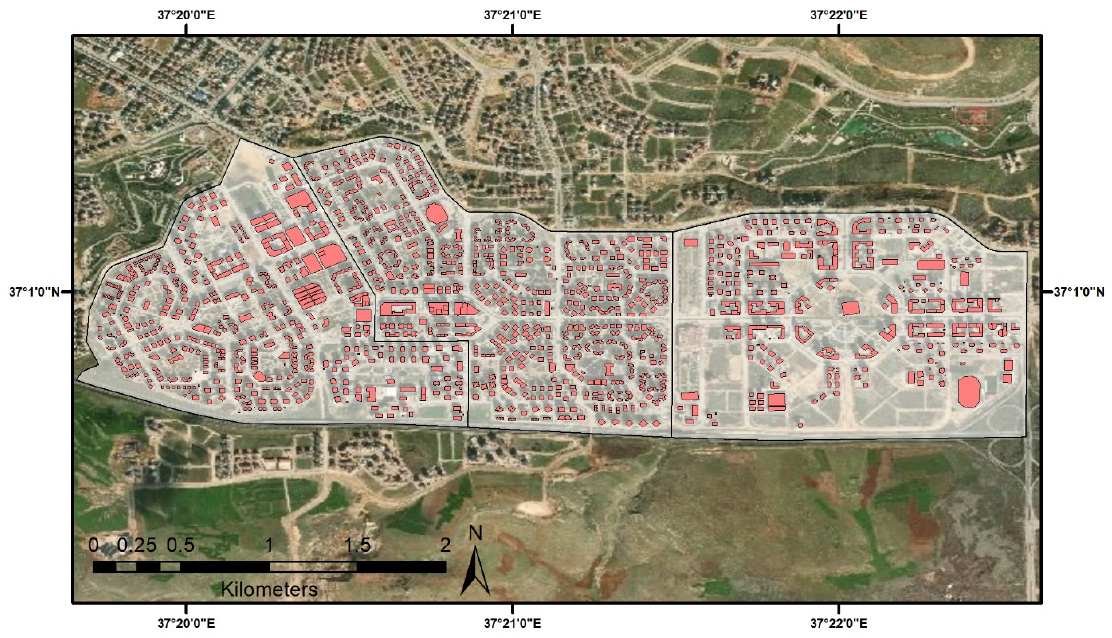
Figure 3. A general view of the boundaries of the modeled city districts and the building footprints located in the north of the project site.